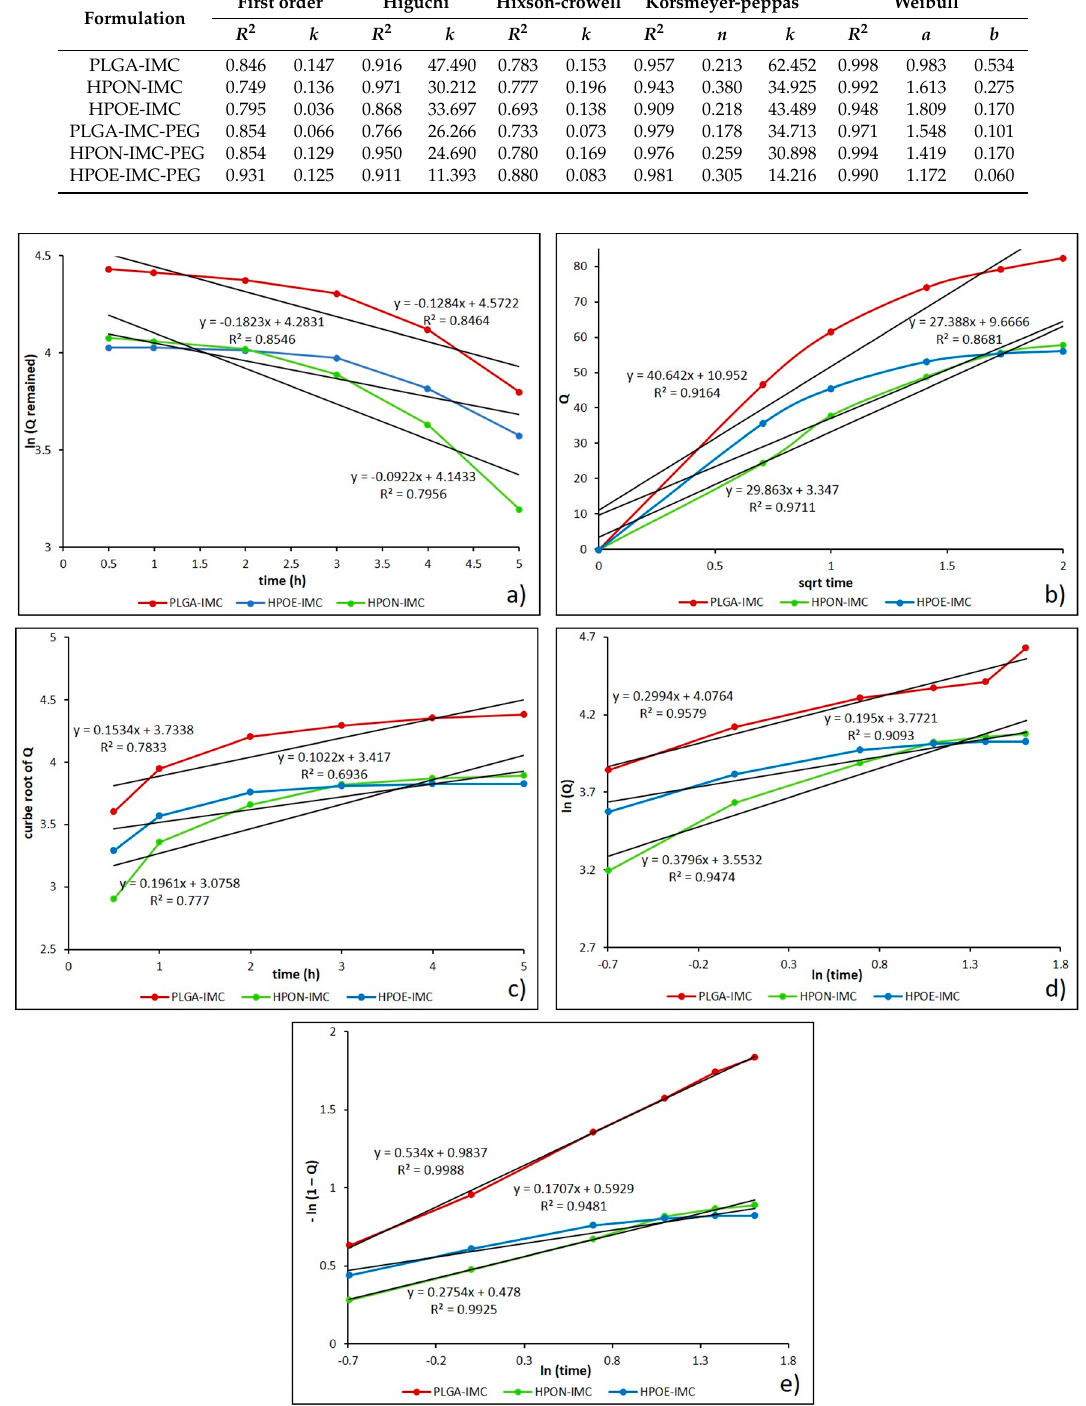
Figure 8. Drug release data fitted to various kinetic models. ( a ) First order; ( b ) Higuchi model; ( c ) Hixson-Crowell model; ( d ) Korsmeyer-Peppas model; and ( e ) Weibull drug release model.